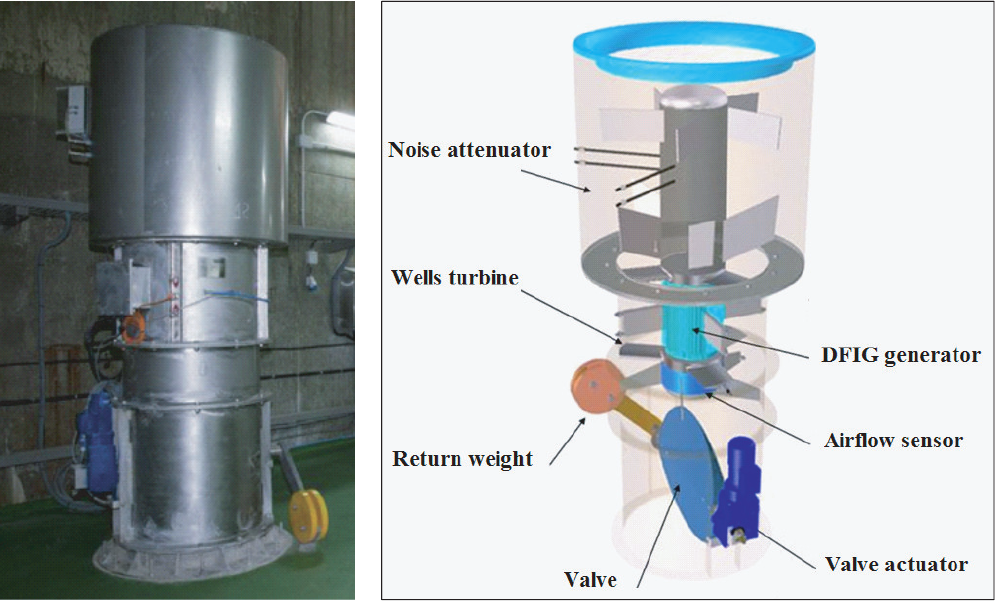
Figure 2. PTO of OWC combining Wells turbine and